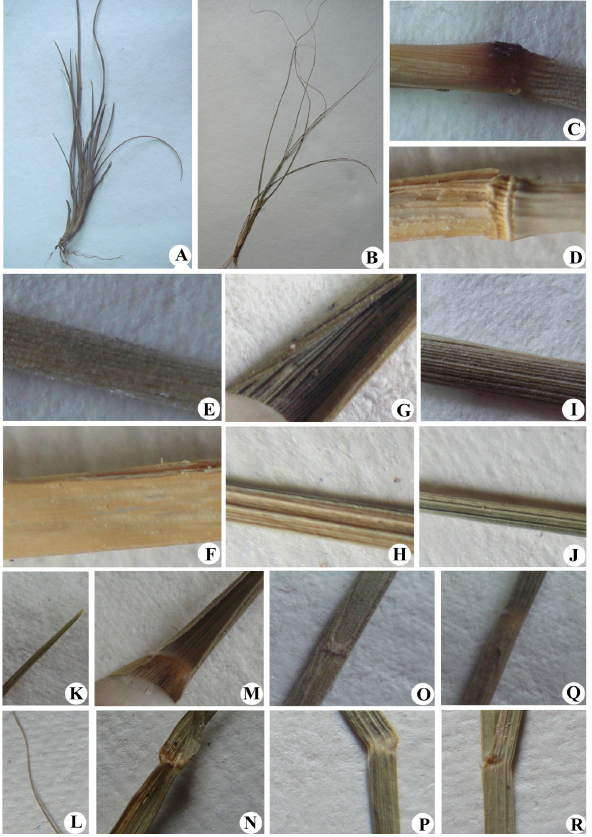
Fig. 1. Characteristic features of the seedlings Fig. 2. Characteristic features of the caryopses (light and scanning electron,